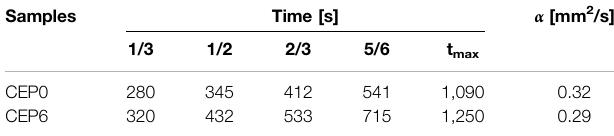
TABLE 3 | The thermal diffusivity of CEP6 and the reference sample.